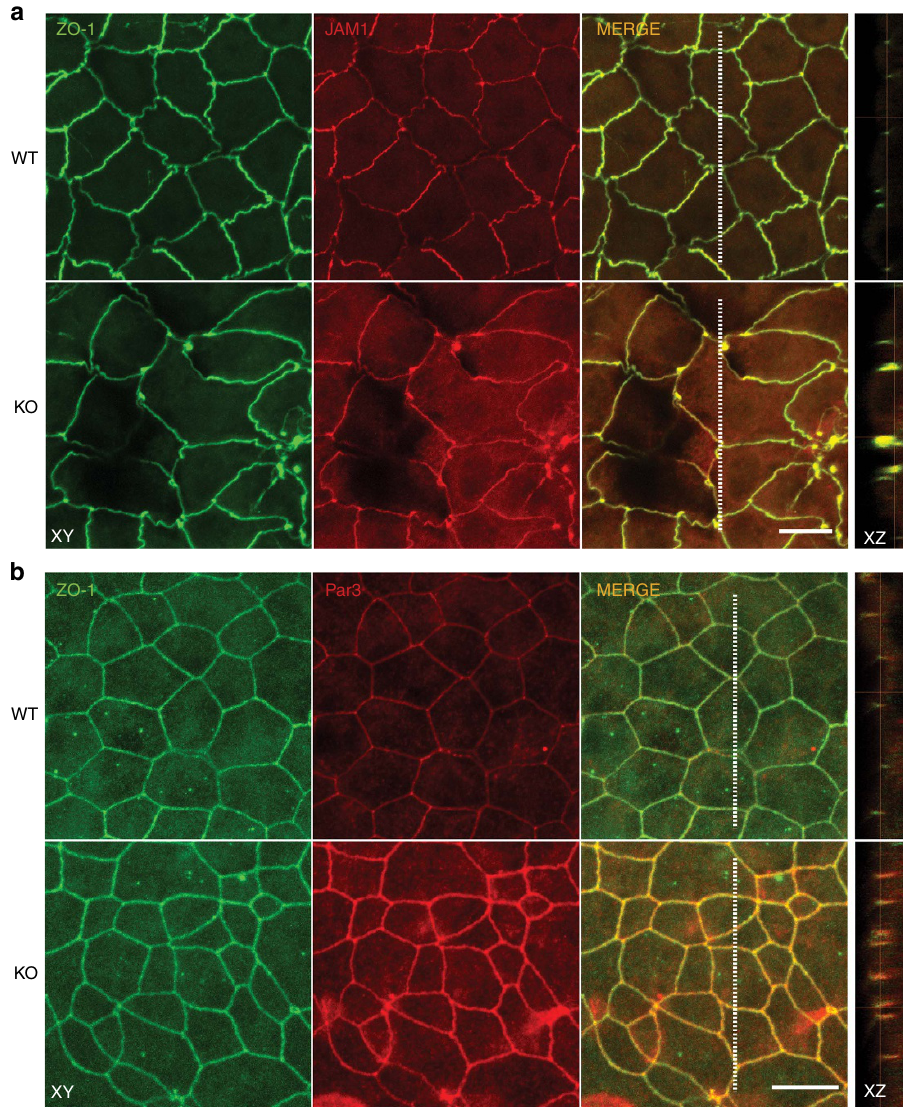
Figure 7 | Alix (cid:2) / (cid:2) CP shows defects in epithelial cell polarity. ( a ) Maximum intensity projections (MIP) of confocal microscopy images of whole-mount WTand Alix (cid:2) / (cid:2) CP ( n ¼ 3) immunostained for ZO-1 (green) and JAM-1 (red). ( b ) WTand Alix (cid:2) / (cid:2) tracheal epithelial cell cultures immunostained for ZO-1 (green) and Par3 (red). The dotted lines in the XY images indicate the corresponding XZ sections. Data are representative of at least three independent experiments. Scale bar, 10 m